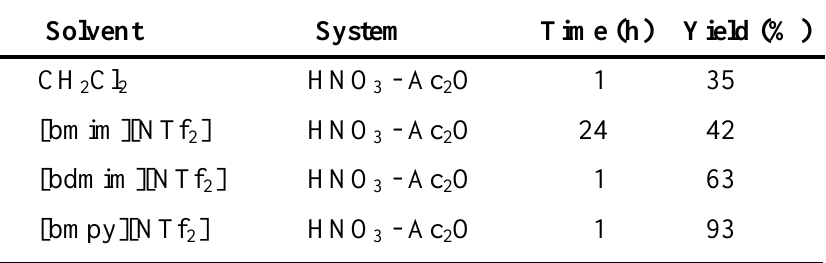
Table 7. Electrophilic aromatic nitration of toluene by acyl nitrates in various